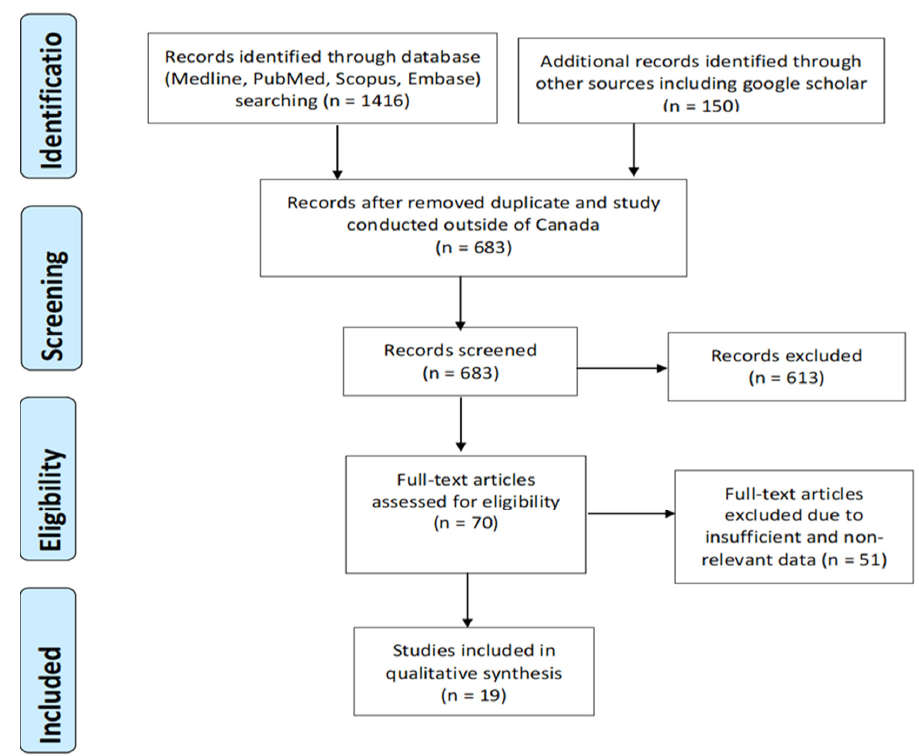
Figure 1. PRISMA flow chart of the literature review and article identification process. PRISMA: Preferred Reporting Items for Systematic Review and Meta-Analysis.